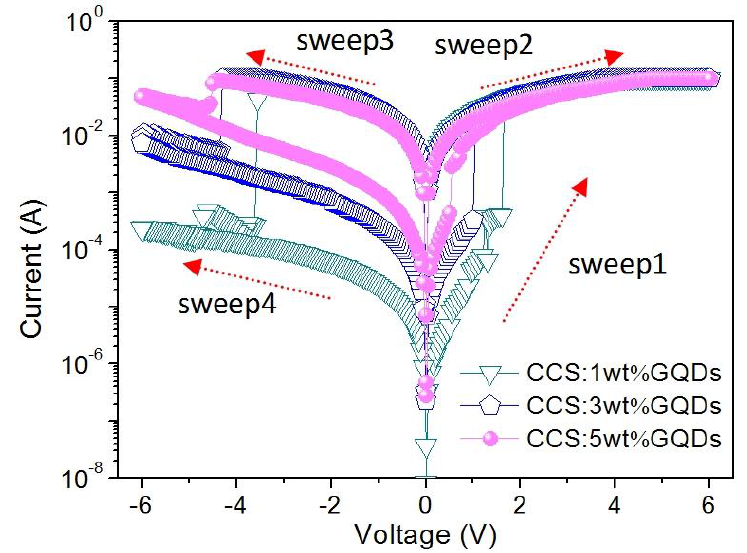
Figure 5. I – V characteristics of the bistable biomemristic behaviors of CCS blended with distinct GQD contents of 1 wt%, 3 wt%, and 5 wt%, respectively.